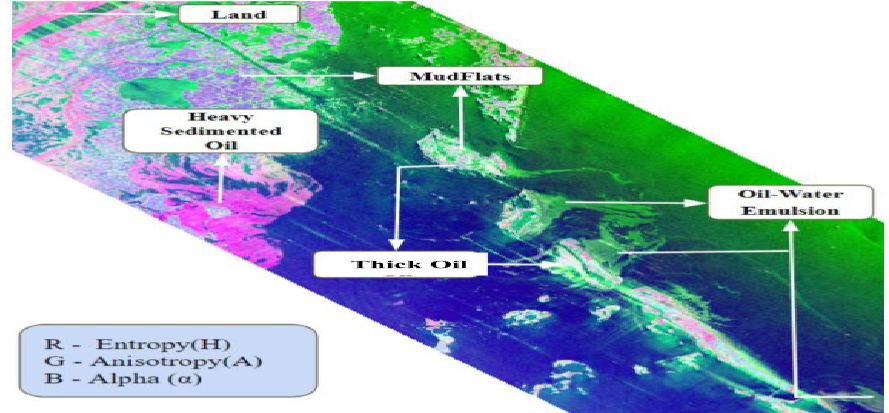
Figure 8. H / A / α decomposition using Conventional